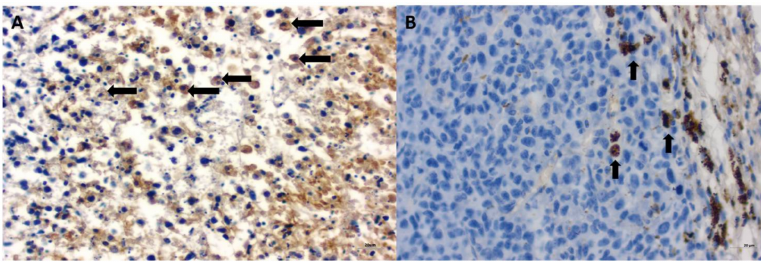
Figure 5. Immunoexpression of tumor-associated macrophages (TAM) in FISS growth in immunodeficient mice treated with Au-GSH-Dox in the tumor core close to the area of necrosis ( A ) and at the tumor periphery ( B ). Visible internalization of Au-GSH with TAM ( B ). Arrows indicate TAM. Bar graph 20 µ